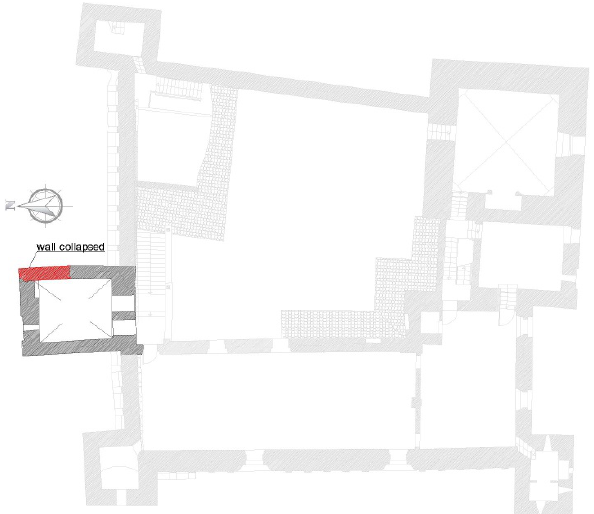
Figure 1. Floorplan of the San Felice sul Panaro Fortress: North Tower highlighted